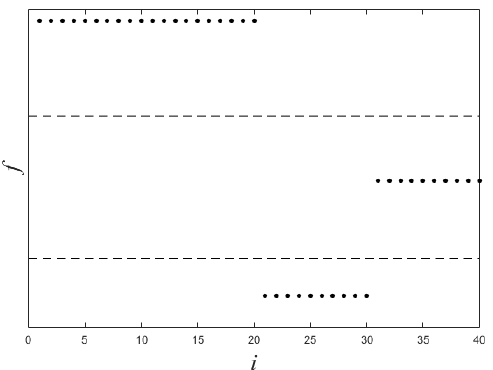
Figure 2. The plot of f for the dataset shown in Figure 1. X-axis means i (i.e., the subscript of x i ), Y-axis means f